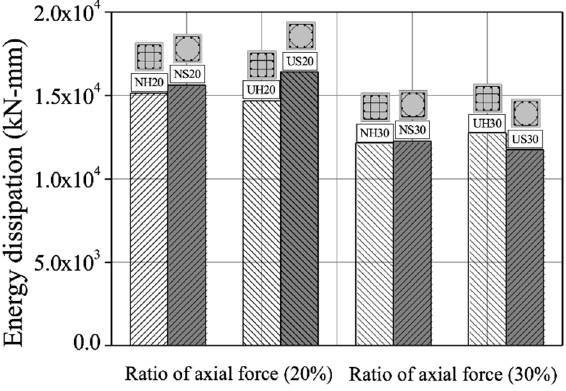
Figure 11. Calculate of energy dissipation (kN-mm).